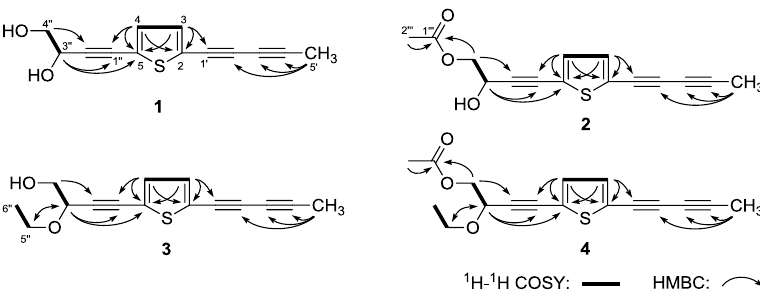
Figure 3. The main 1 H- 1 H COSY and HMBC correlations of 1 – 4 . Table 1. 1 H- and 13 C-NMR data for 1 in CD 3 OD and CDCl 3 .